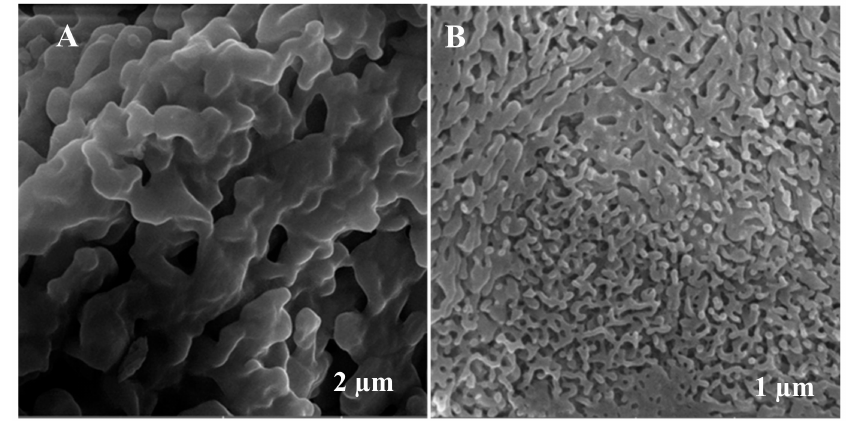
Figure 2. FEG-SEM micrographs of powder WOL. ( A ) 40000 × and ( B ) 20000 ×